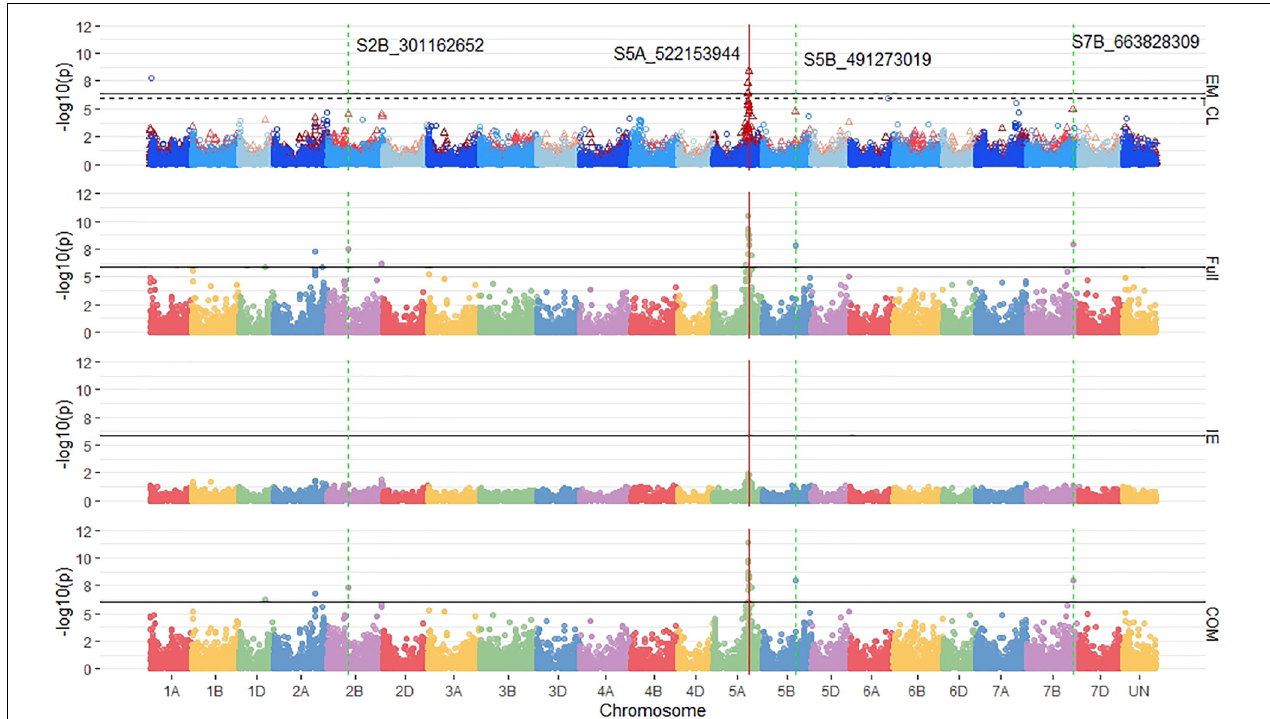
FIGURE 7 | Stacked Manhattan plots for multi-trait genome-wide association studies (MT-GWASs) using seedling and emergence overlapped (EM_CL), the full effect (Full), interaction effect (IE), and common effect (COM) multi-trait mixed models for identifying significant loci controlling deep-sowing seedling emergence and coleoptile length in a Pacific Northwest winter wheat diversity panel (DP) phenotyped across trials from 2015 to 2017 in Lind, WA. For the overlapped plot, EM_CL, red triangles display GWAS results for seedling emergence, and blue circles identify GWAS results for coleoptile length. Significant markers using a Bonferroni cut-off with an alpha = 0.05 are placed above the solid black line for seedling emergence and the dashed black line for coleoptile length. Significant markers across three models are highlighted with a solid red vertical line, and significant markers across two models are highlighted with a dashed green vertical line identifying their